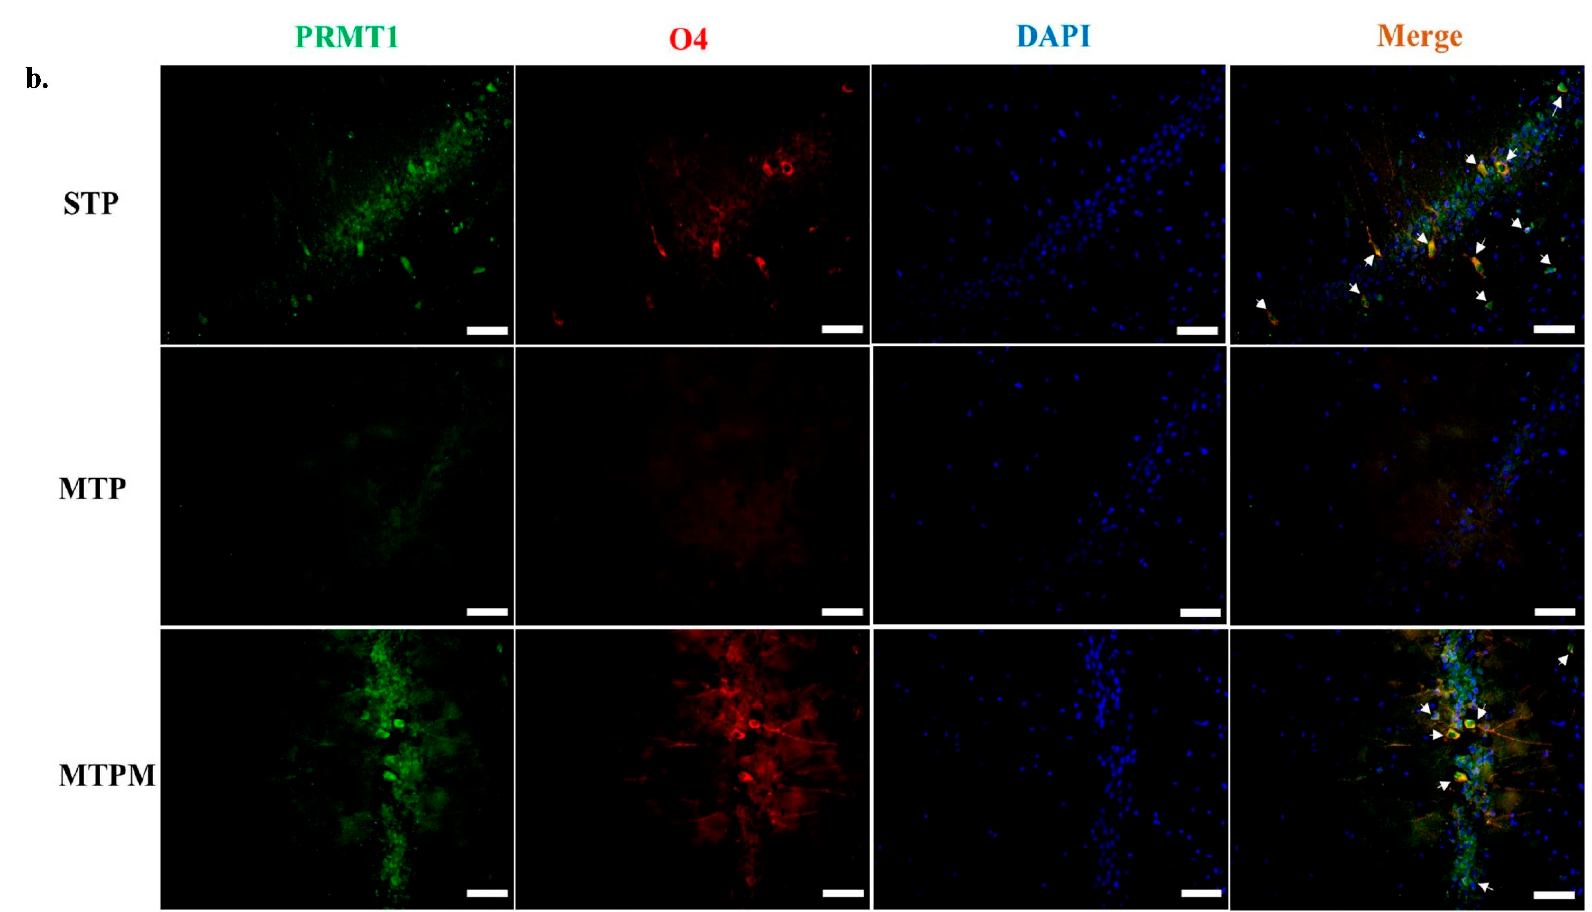
Figure 5. Interactions of PRMT1 with BDNF and oligodendrocyte progenitor cells were disturbed by MTX treatment. In contrast, melatonin prevented the disturbances of MTX. ( a ) Immunofluorescence staining of PRMT1 and BDNF in the cornu ammonis 1 (CA1) area of hippocampus CA1 area revealed colocalization of PRMT1 and BDNF. MTX treatment resulted in a decrease in staining of both PRMT1 and BDNF, and melatonin could reverse the effect. Hippocampus CA1 double-stained PRMT1 (Green), BDNF (Red), DAPI (Blue) indicated nuclei. ( b ) Immunofluorescence staining of the early stage oligodendrocyte progenitor cells (O4 cells) revealed decrease in PRMT1 expression MTX treatment and the effect could be rescued by melatonin treatment. Hippocampus CA1 double-stained PRMT1 (Green) and oligodendrocyte marker O4 (Red), DAPI (Blue) indicated nuclei. The arrow indicated co-localization of PRMT1/BDNF or PRMT1/O4 in CA1 area. Each bar indicated 50 μ m.